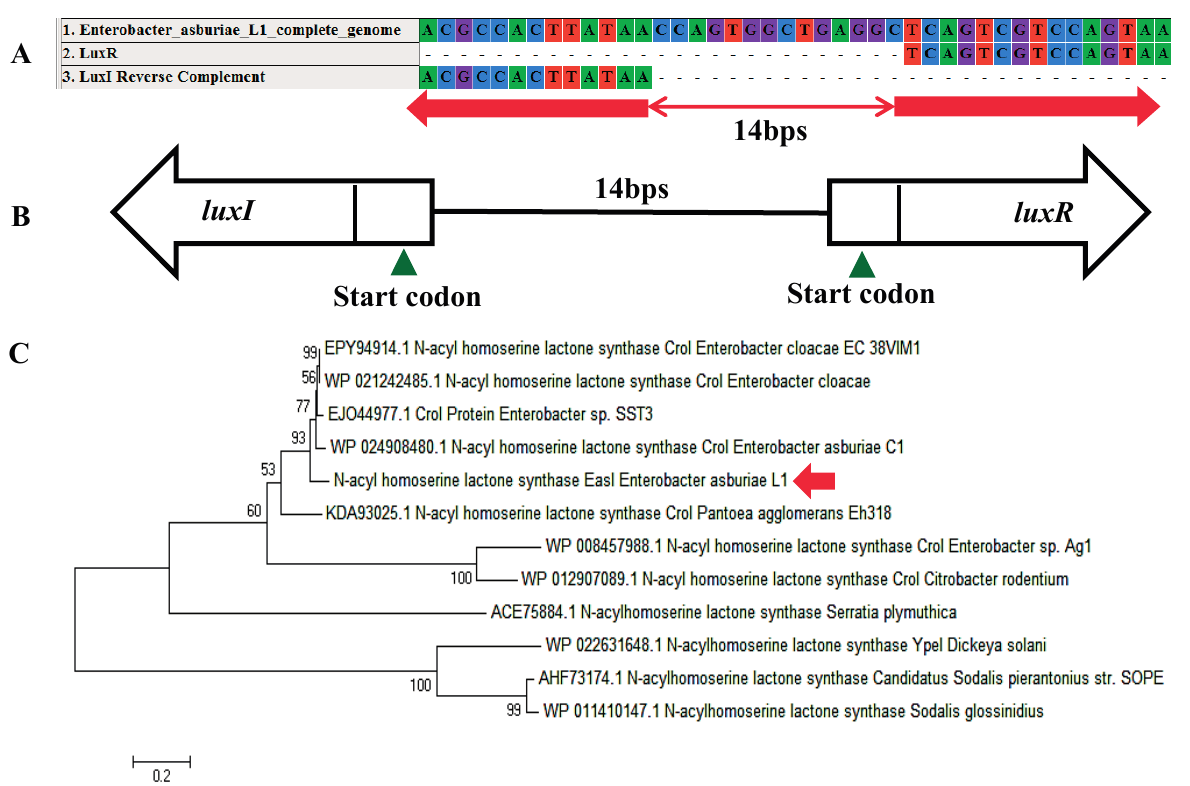
Figure 6. N -acyl homoserine lactone synthase EasI and transcriptional regulator of E. asburiae L1. ( A ) The alignment of luxI and luxR genes with 14 bps apart; ( B ) The arrows showed the transcriptional direction of luxI and luxR genes while the green triangle indicated the site for start codons and ( C ) Phylogenetic analysis of E. asburiae L1 luxI gene. The tree was constructed based on the similar LuxI protein sequences by Neighbor-Joining with bootstraps value of 1000